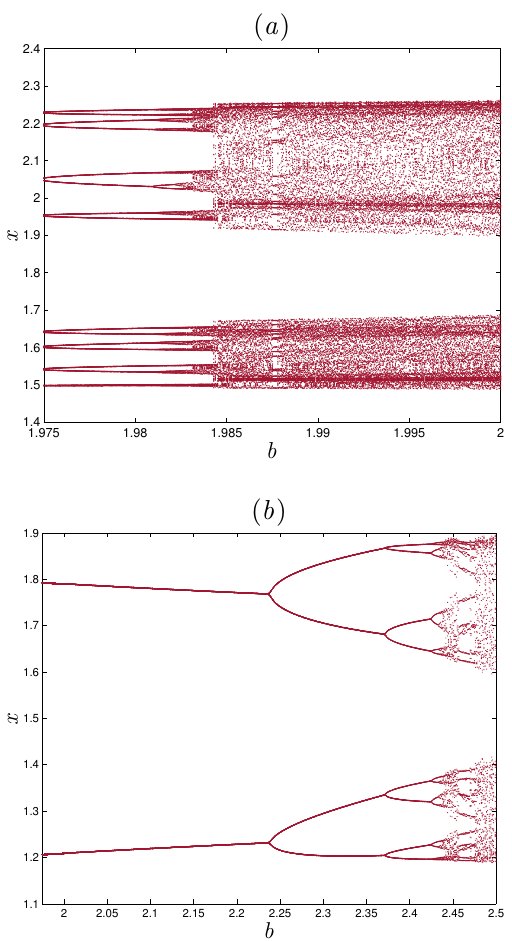
Figure 2. Bifurcation diagrams of the fractional-order map (6) when the parameter b is varied with the different values of order ν : ( a ) for ν = 1; ( b ) for ν = 0.7457.